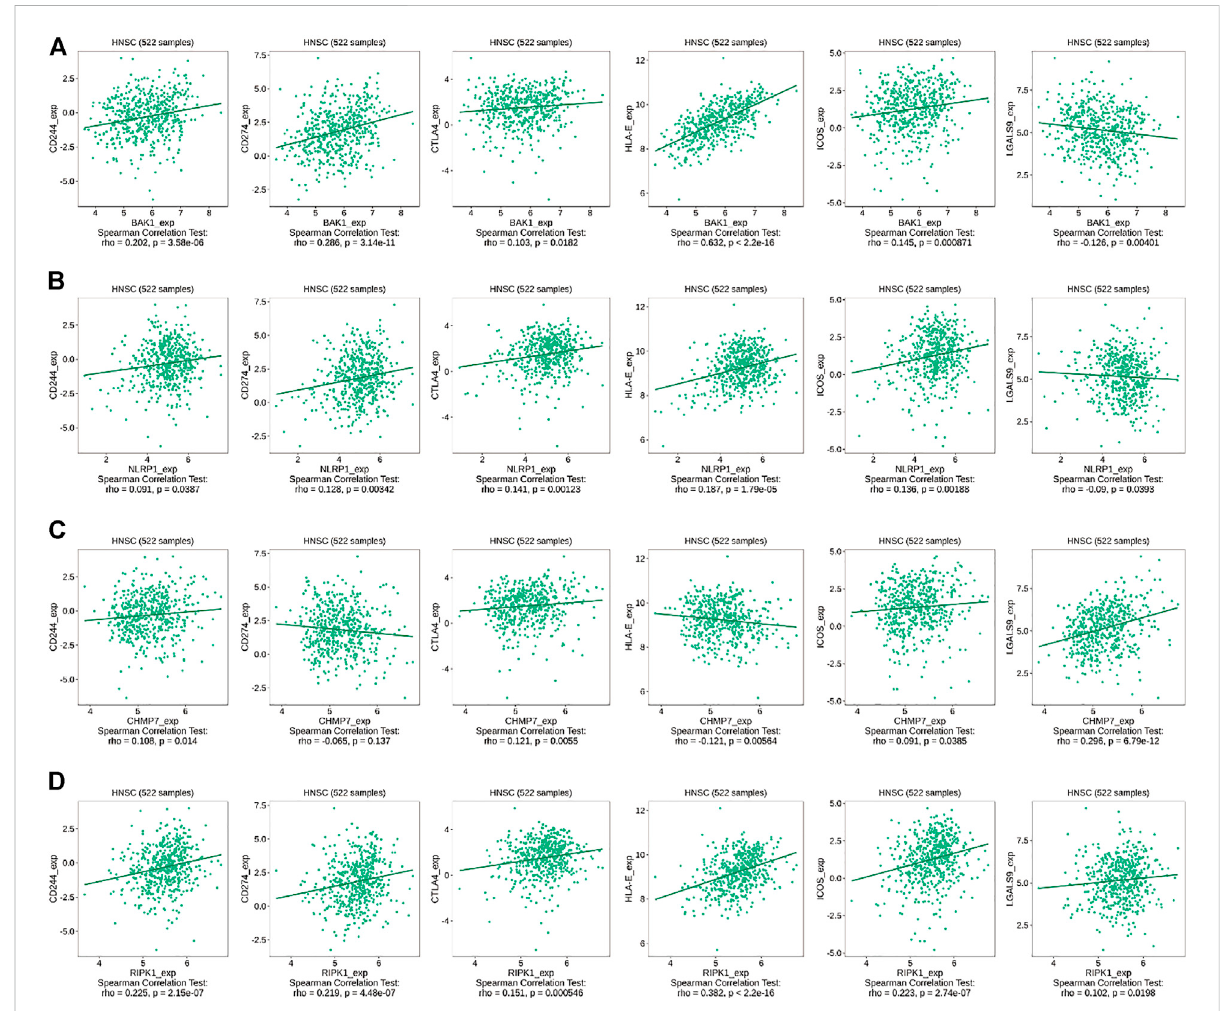
FIGURE 10 Correlation between BAK1 , NLRP1 , CHMP7 , and RIPK1 genes and immunomodulators. (A) Correlation between BAK1 gene and CD244, CD274, CTLA4,HLA-E,ICOS,andLGALS9inHNSCCaccordingtoTISIDBdatabase; (B) Correlationbetween NLRP1 geneandCD244,CD274,CTLA4,HLA-E, ICOS, and LGALS9 in HNSCC according to TISIDB database; (C) Correlations between CHMP7 gene and CD244, CD274, CTLA4, HLA-E, ICOS, and LGALS9 in HNSCC according to TISIDB database; and (D) Correlations between RIPK1 gene and CD244, CD274, CTLA4, HLA-E, ICOS, and LGALS9 in HNSCC according to TISIDB